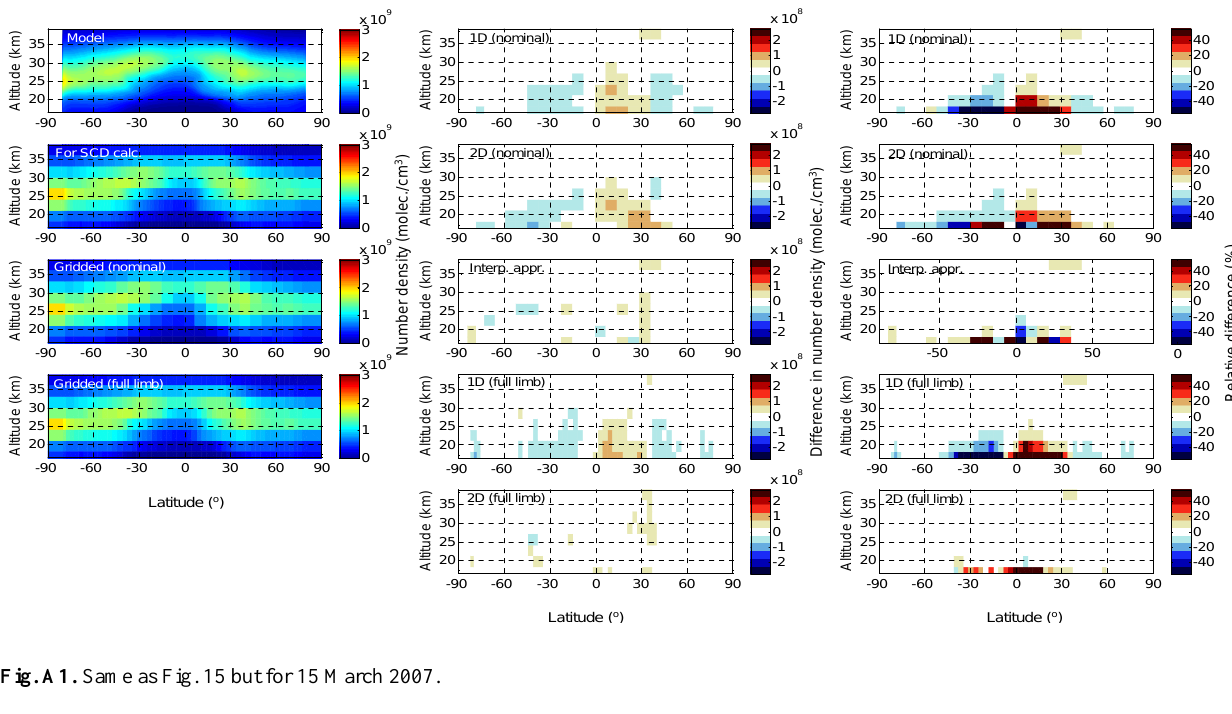
Fig. A1. Same as Fig. 15 but for 15 March 2007.